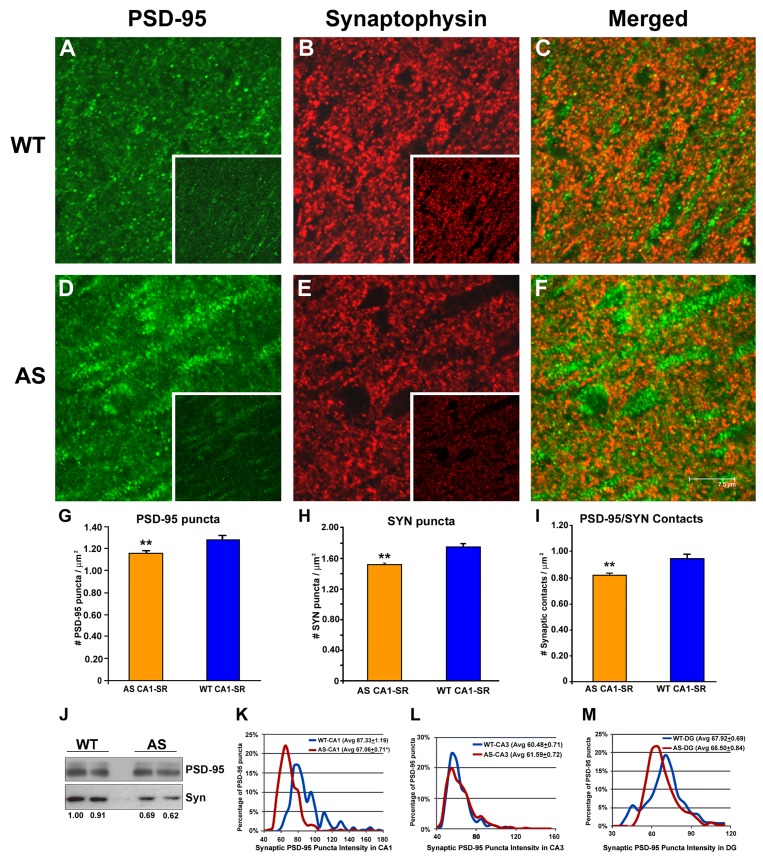
Decreased synaptic density in the CA1 hippocampal area.PSD-95 (green, A and D) and SYN (red, B and E) antibodies were used to stain synapses (merged, C and F) in stratum radiatum (SR) of the hippocampal area CA1. Here differences in PSD-95 and SYN staining were observed between WT and AS mice. In the case of SYN, there was a noticeable decline in staining intensity in the AS mouse (see unthresholded image in the inset of [E] compared to the unthresholded image taken from the WT mouse (see inset of [B]). Quantitative data for PSD-95 (G) and SYN (H) show a significantly reduced number of PSD-95 and SYN stained puncta in the AS mouse. Importantly, the total number of PSD-95/SYN contacts (synaptic density) was also decreased in the AS mouse (I). Western blot analysis of WT and AS hippocampus shows no visual differences in PSD-95 levels between WT and AS mice (J); however, there was roughly a 35% lower level of expression of SYN in AS than in WT. Measurement of synaptic PSD-95 puncta intensities are shown in CA1 (K), CA3 (L), and DG (M). In both CA1 (K) and to a lesser extent in the DG region (M), there was a shift to the left with respect to the number of puncta that were less intensely stained in the AS mouse as compared with WT. In contrast no differences were noted in CA3 (L). Immunostained sections were imaged on a confocal microscope using 100× objective and a 4× zoom. Scale bar = 7.5 µm. (*p<0.05).